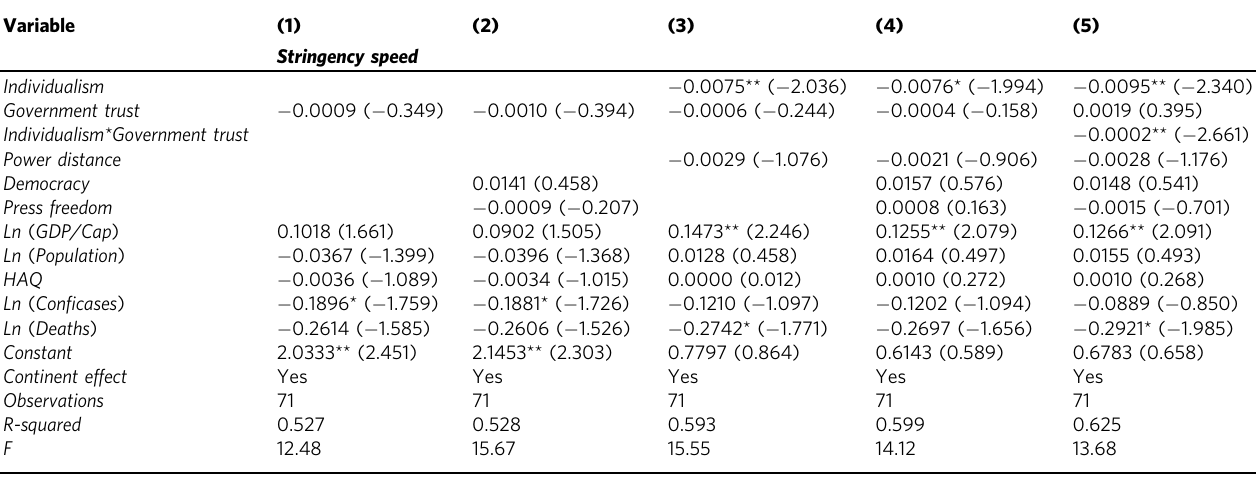
Table 4 Regression results on stringency speed.